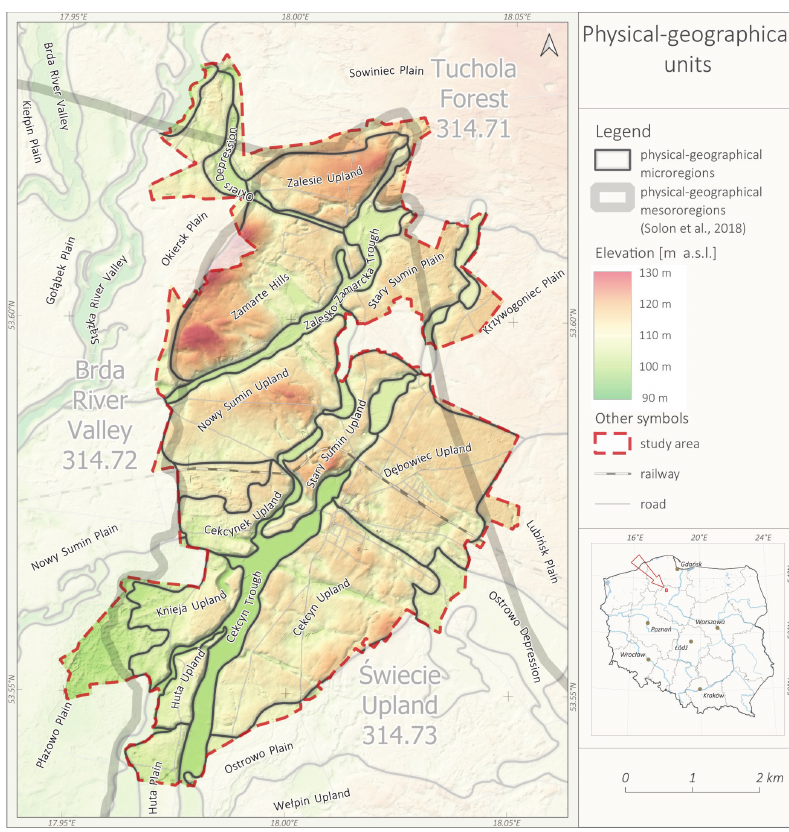
Figure 2. Designated physical–geographical units in the study area.